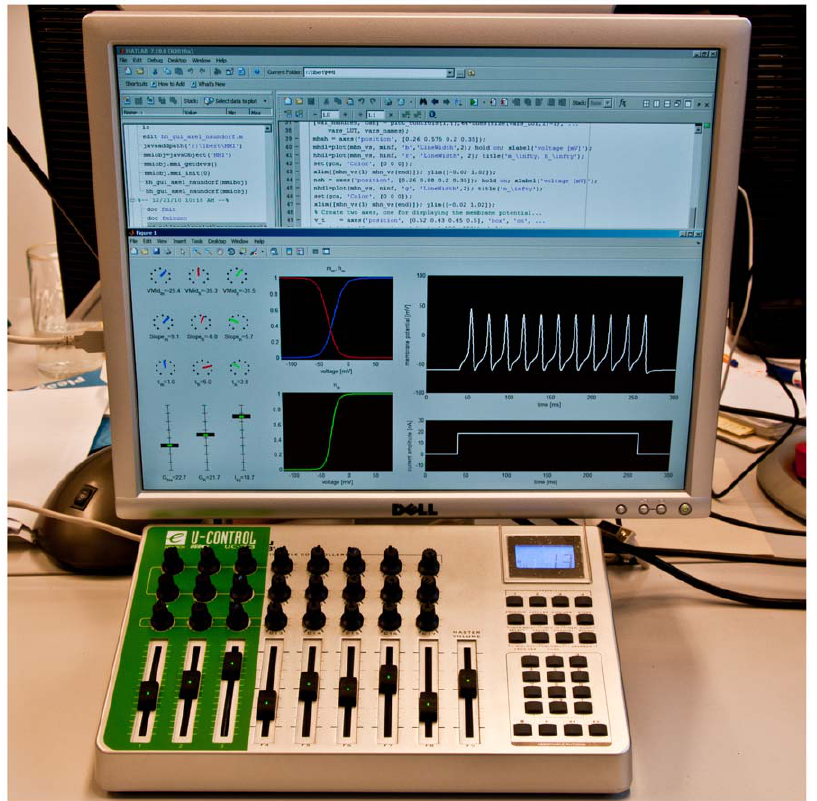
Figure 1. Using a MIDI device to control a computer simulation. On the computer screen, the application (in this case, a simulation of the Hodgkin-Huxley model) is depicted, with the actually used control elements of the MIDI controller (highlighted by a green template) replicated on the left side of the application. The simulation is updated on every control element change, and the latest results are immediately plotted on the right side of the application window.